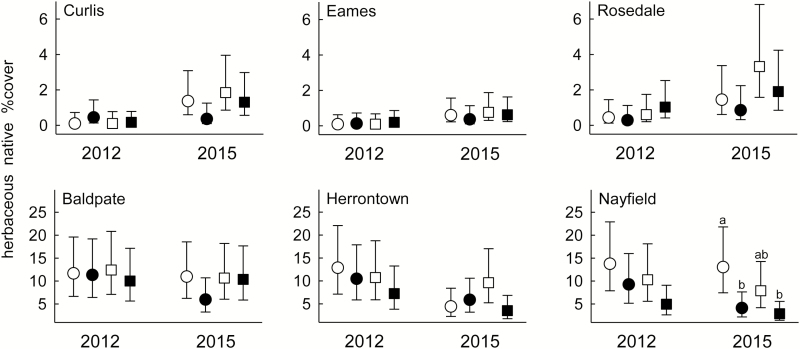
Fall cover (%) of herbaceous native species in 2012 and 2015 within six suburban forests in central New Jersey, in fenced plots (square) or in plots with deer access (circles) with (filled symbols) or without (open symbols) Microstegium vimineum seed addition. Data are means ± 95 % CI (back-transformed from logits) of 8–10 plots. Different letters above means indicate significant differences in a forest within a year (Tukey–Kramer adjusted P < 0.05).